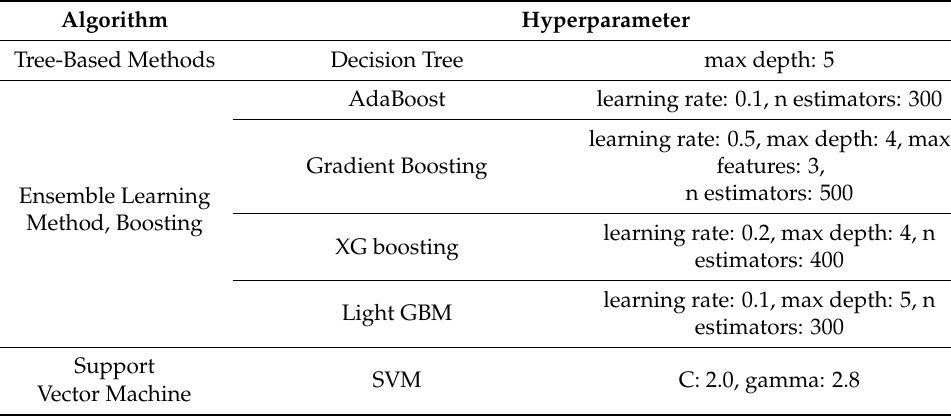
Table 7. Summary of the hyperparameters of the